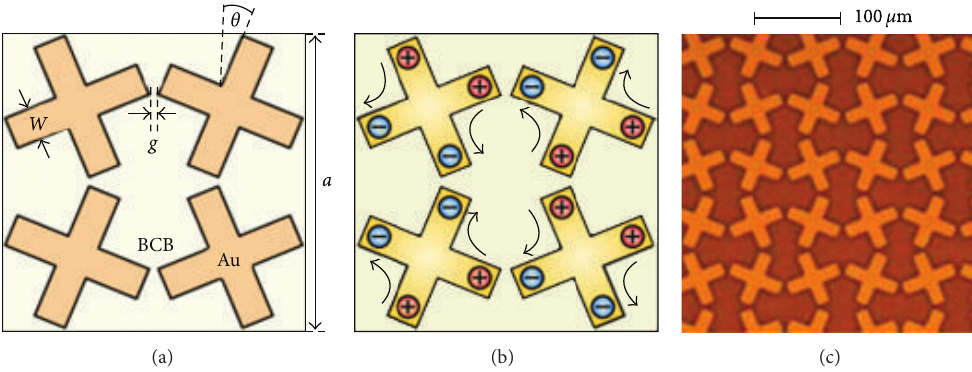
Figure 9: Geometry parameters of the metamaterial unit cell. 𝑎 = 140 𝜇 m, 𝑤 = 15 𝜇 m, 𝑔 = 4 𝜇 m, and 𝜃 = 22.5 ∘ . The metamaterial consists of gold (Au) crosses on top of a BCB film. (b) Distribution of charges ( +,− ) and currents (arrows) at resonance when excited by a horizontally polarized incident THz wave. (c) Microscope image of a fabricated metamaterials [44].